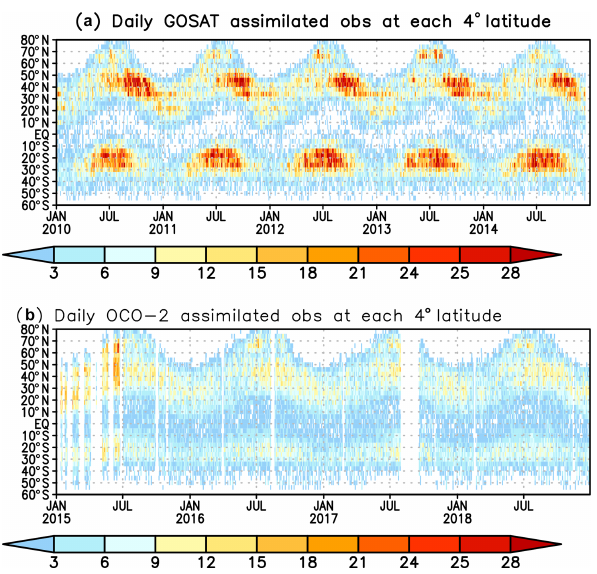
Figure B3. Daily number of ACOS-GOSAT b7.3 (a) and OCO-2 super observations (b) assimilated in the top-down inversions.